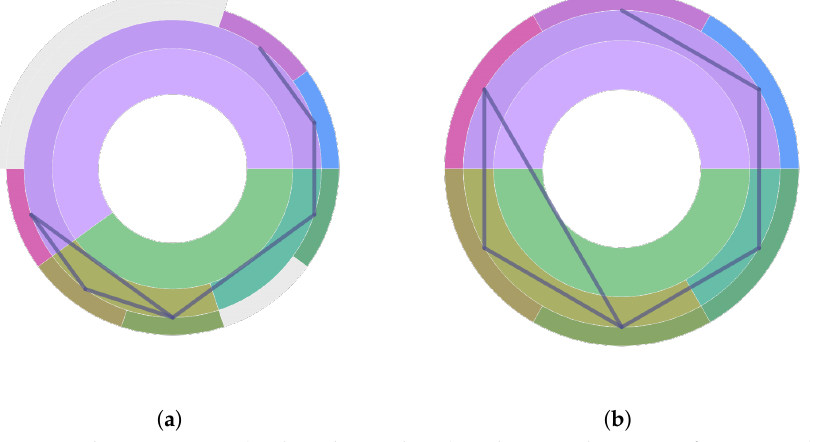
Figure 3. Filtering out H1 (and its descendants) and N2 on the scene of Figure 2. ( a ) Filtered-out nodes are attenuated in gray color and their connections are removed from the visualization. ( b ) Both the filtered nodes and their connections are removed from the view, thereby rearranging the